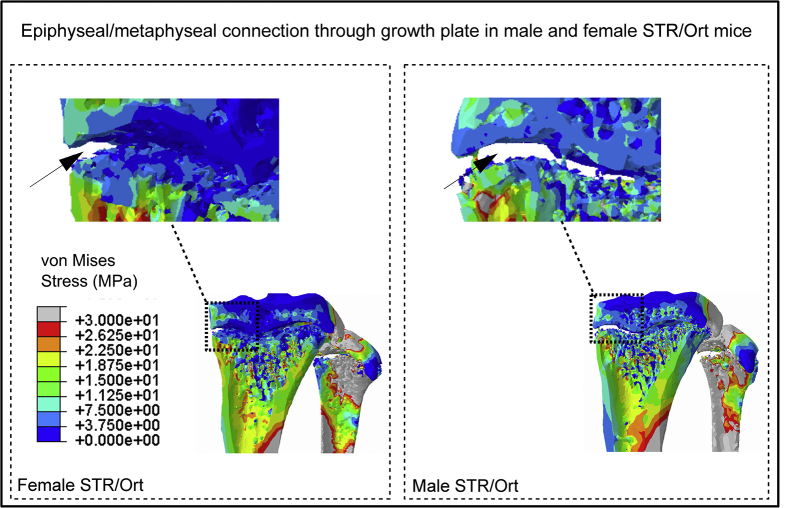
Epiphyseal/metaphyseal region of 10-week old male and female STR/Ort mice showing von Misses stress and the extent of growth plate connectivity.